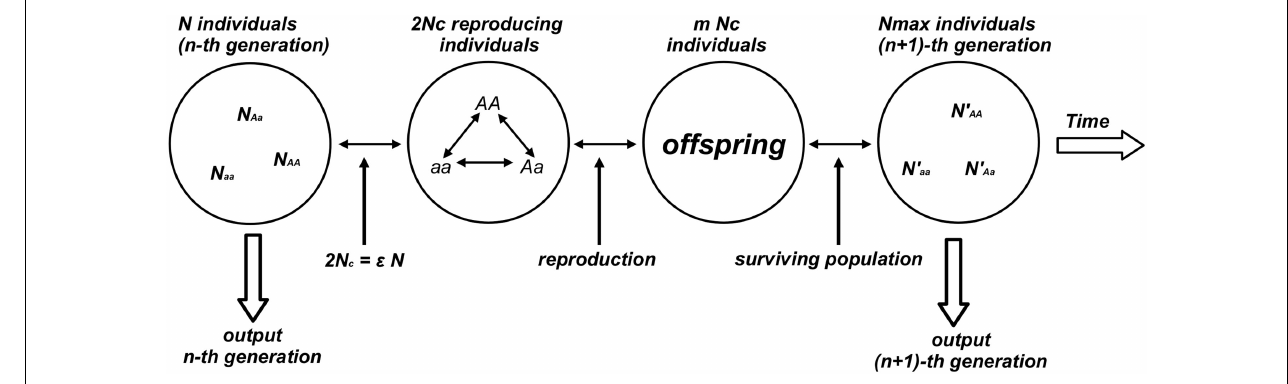
selected according to specific rules (random or not) and reproduction takes place with a mean number m of descendants per couple.When the population grows at geometric rate ( m > 2) a prescribed number N max of individuals composes the surviving population defined as the ( n + 1)-th